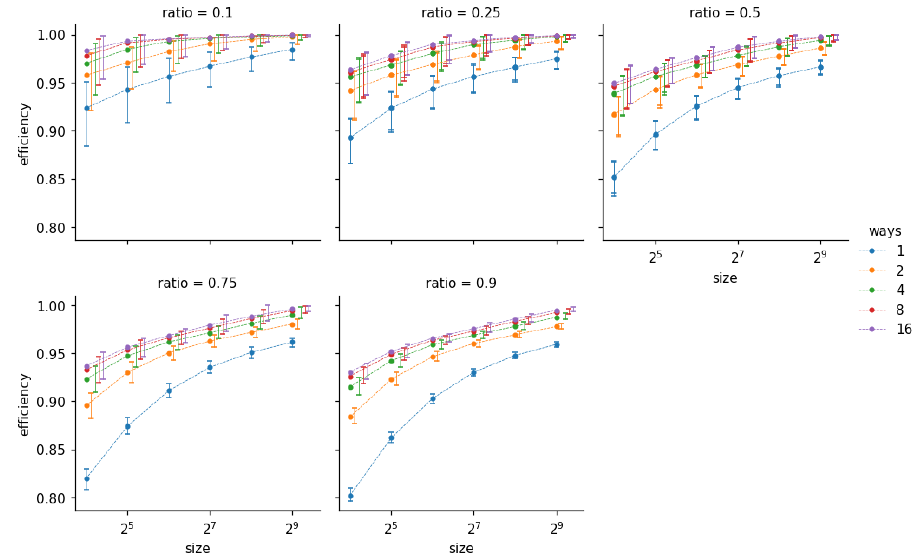
Figure 7. Efficiency results as a function of number of entries in the flow table. Each sub-graph represents a different ratio of the test composition R . Each data series represents the flow table associativity A (number of ways). The X axis has logarithmic scale: X = log